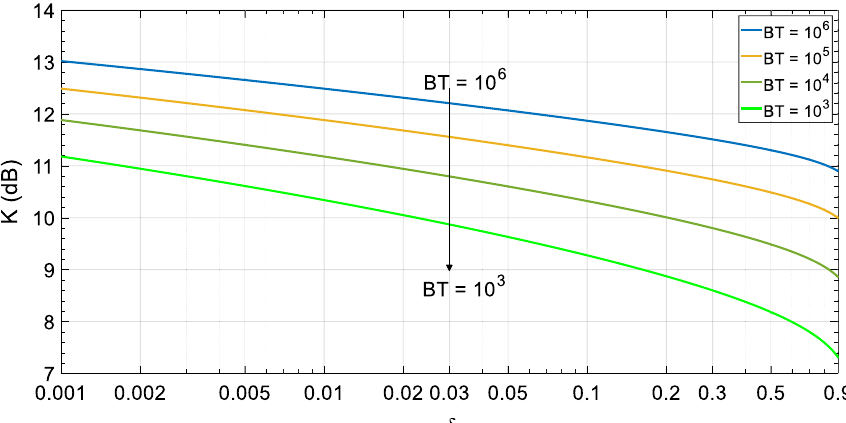
Fig. 10 Parameter K (dB) in Eq. (4) versus the probability δ with BT varying,